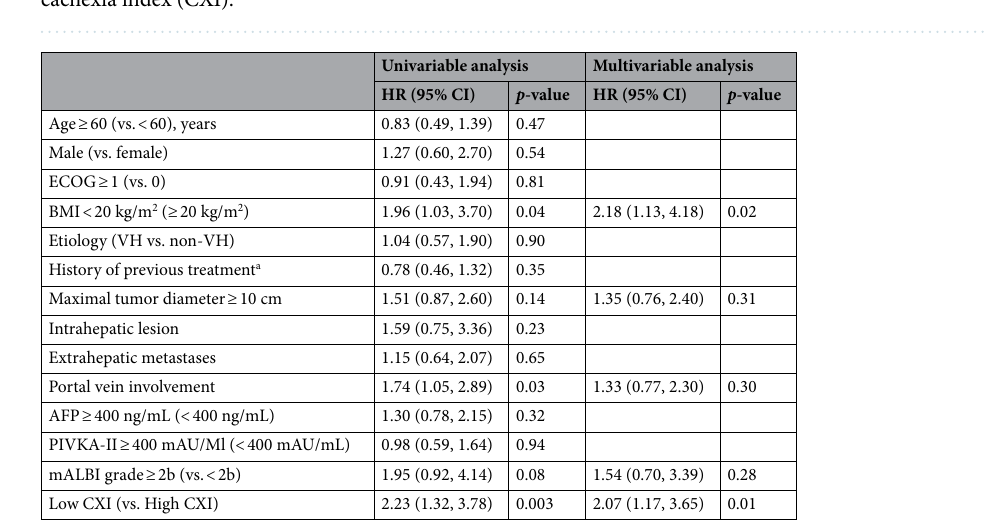
Table 4. Multivariable Cox regression analysis for overall survival. HR: hazard ratio; CI: confidence interval; ECOG: Eastern Cooperative Oncology Group; BMI: body mass index; VH: viral hepatitis; BCLC: Barcelona Clinic Liver Cancer; AFP: alpha-fetoprotein; PIVKA-II: Protein Induced by Vitamin K Absence or Antagonist-II; mALBI grade: modified ALBI grade; CXI: cancer cachexia index. a Defined treatment history of resection, liver transplantation, radiofrequency ablation, transarterial chemoembolization, transarterial radioembolization and radiation therapy.